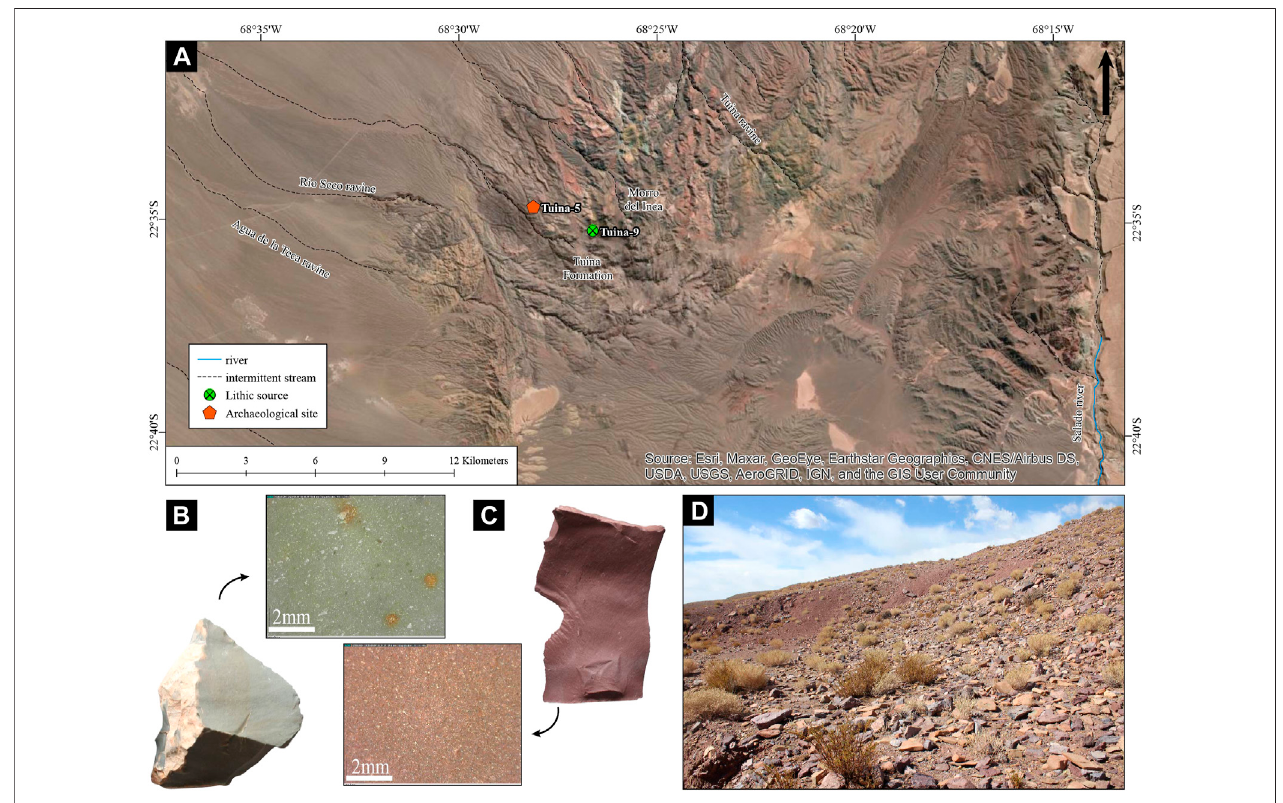
FIGURE 11 | Cerros de Tuina: (A) geological context; (B) raw material samples; (C) raw material samples; (D) Tuina-9 quarry-workshop site.